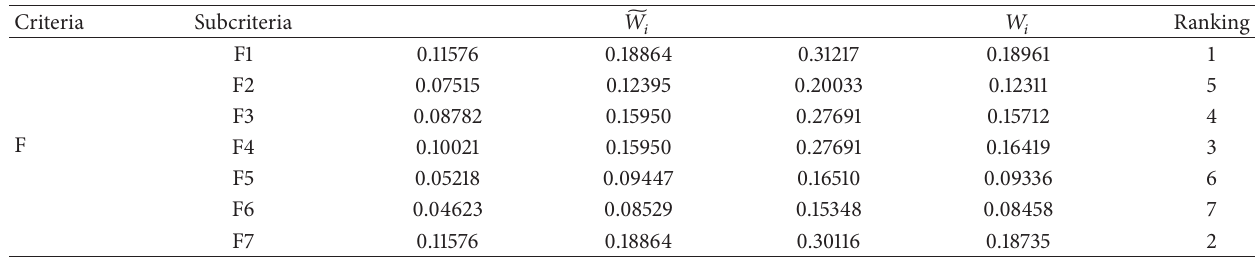
Table 11: Fuzzy and crisp weights and ranking scores for subcriteria in financial